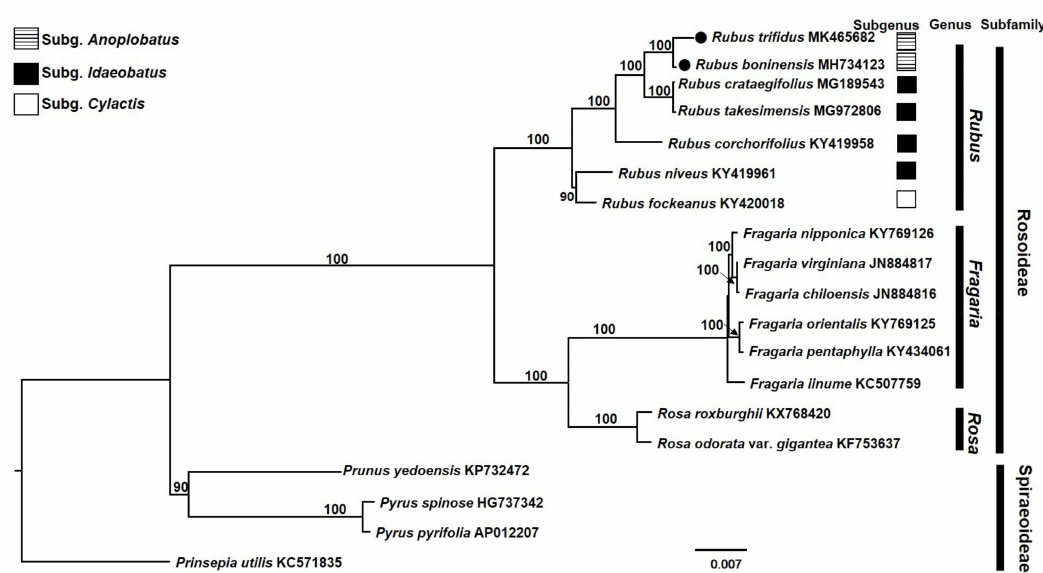
Figure 6. The maximum-likelihood (ML) tree inferred from 19 representative species of Rosaceae. The bootstrap value based on 1000 replicates is shown for each